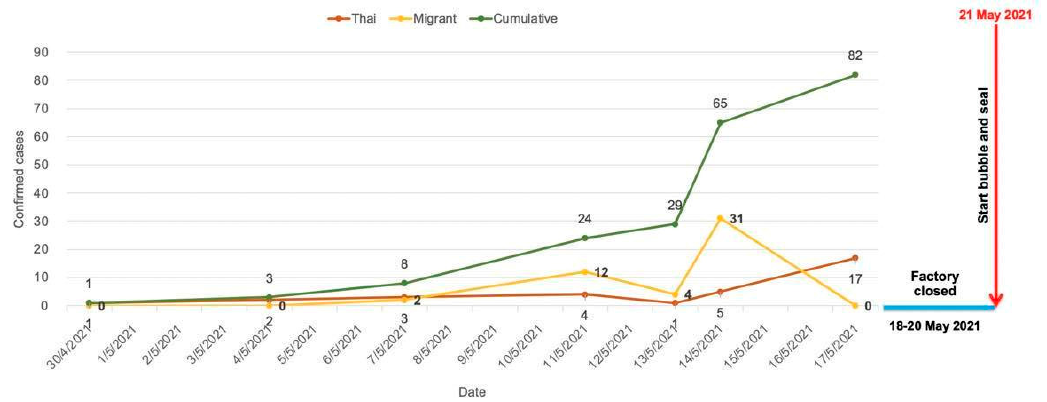
Figure 1. Date of diagnosis and number of RT-PCT-confirmed COVID-19 cases before start- ing the Bubble and Seal program. Bubble and Seal